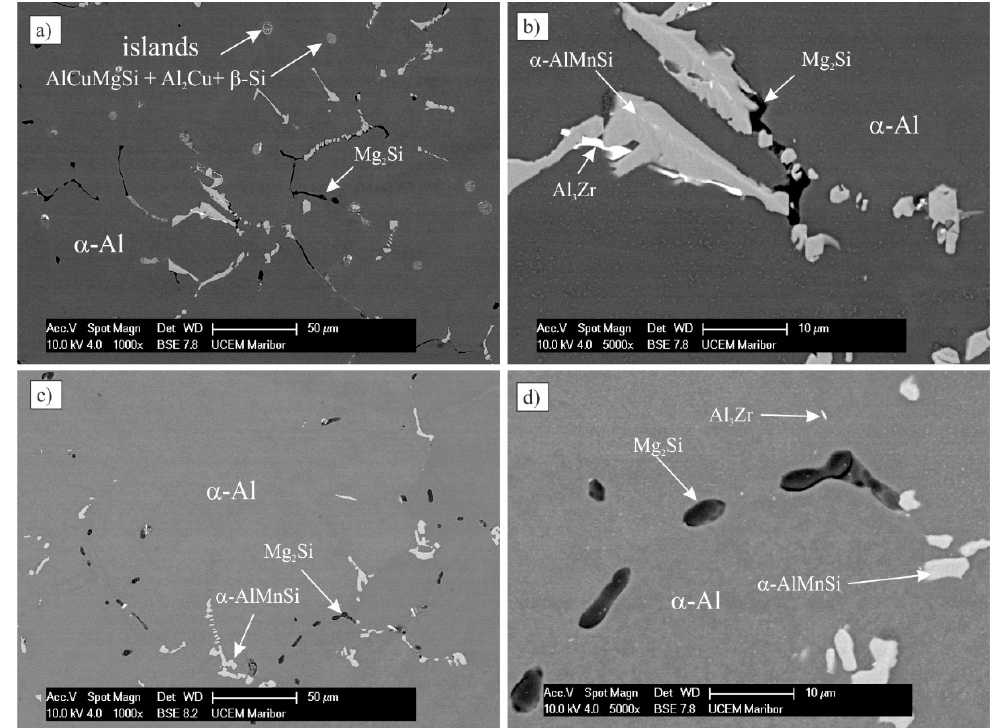
Figure 4. The backscattered electron micrographs (SEM) of the alloy AA 6086 in the as-cast condition ( a , b ) and after homogenization treatment ( c , d ).